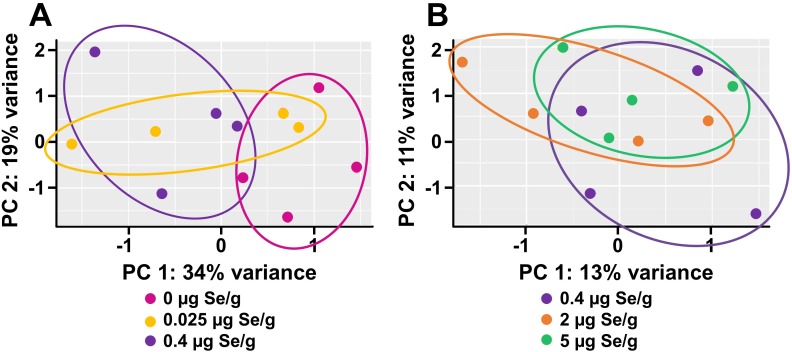
Principal component analysis (PCA) of liver transcripts (n = 17,100) from poults supplemented with graded levels of Se for 28 d.(A) Analysis of low-Se treatments in experiment 1; (B) Analysis of high Se treatments in experiment 2.